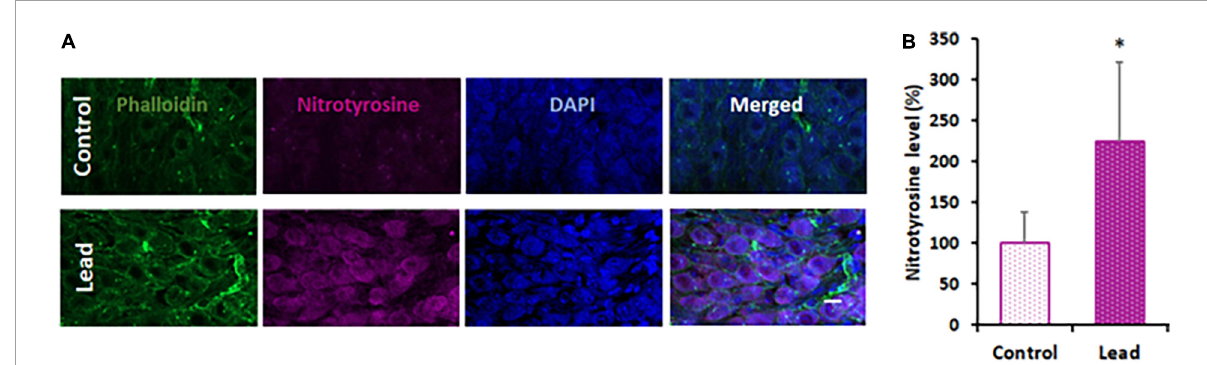
FIGURE5 Lead-induced cochlear nitrative stress. (A) Spiral ganglions probed with anti-nitrotyrosine (magenta stain) indicated an increase in the level of nitrotyrosine after lead exposure. Phalloidin was used to stain actin (green) and DAPI was used to stain the nucleus (blue). Images are representative of 4–5 replicates, scale bar = 10 µ m. (B) Quantification of nitrotyrosine staining indicated a significant increase in the spiral ganglion cells of lead-exposed mice. The results are expressed as mean ± standard deviation, * p < 0.05, n =